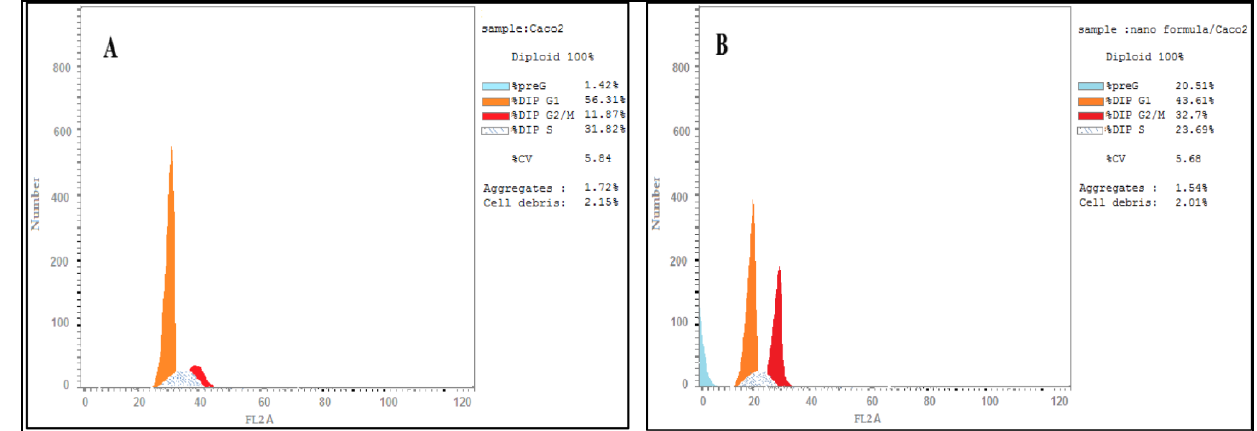
Figure 7. ( A ) Cell cycle analysis for Caco-2 cancer cell line (control); ( B ) cell cycle analysis for Caco-2 cancer cell line was treated with CA-BSA-NPs.